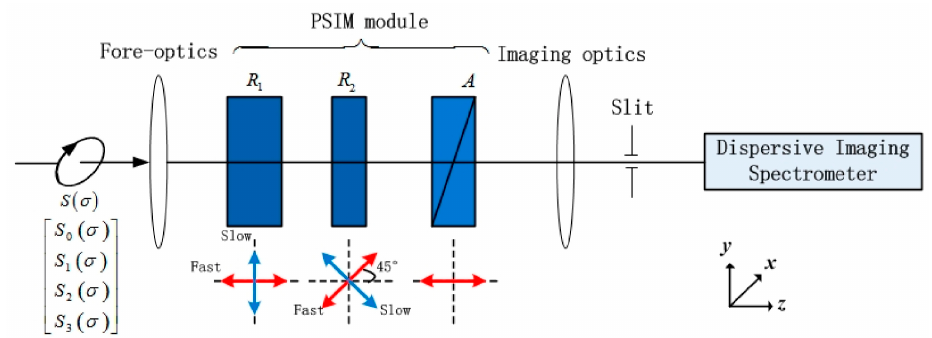
Figure 1. Optical schematic of the fieldable channeled spectropolarimeter.